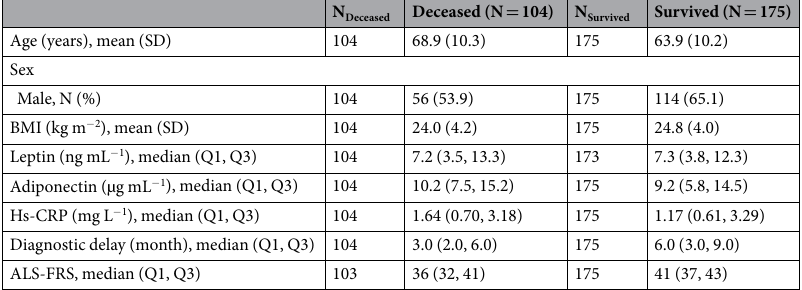
Table 3. Characteristics of ALS Patients (N = 279) with mortality follow-up by survival status.